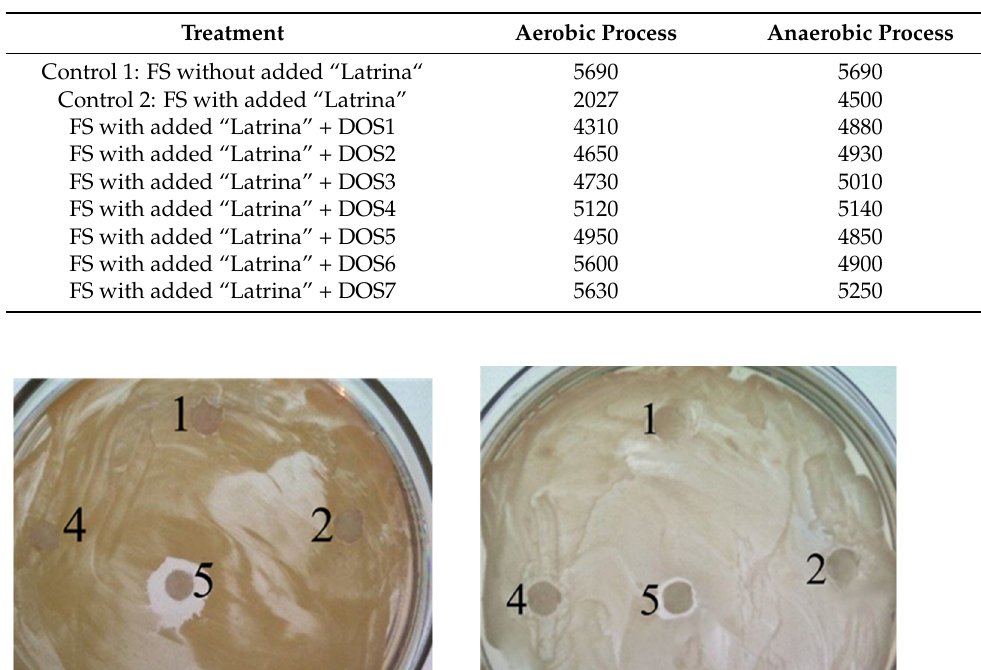
Table 6. BOD 5 (in mg O 2 /L) of FS in control and experimental treatments incubated for 5 days under aerobic or anaerobic conditions.